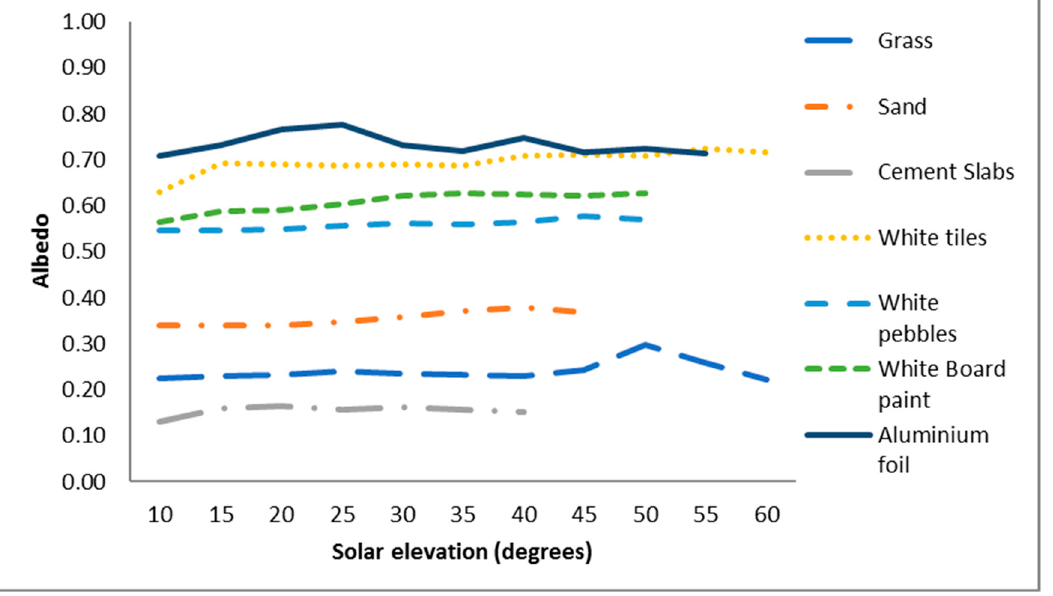
Figure 3. Impact of solar elevation on the researched materials.